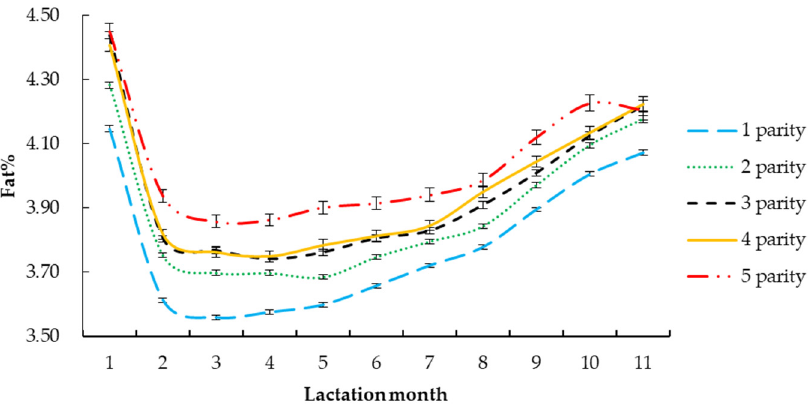
Figure 2. Lactation curves of Wood model for different parities.